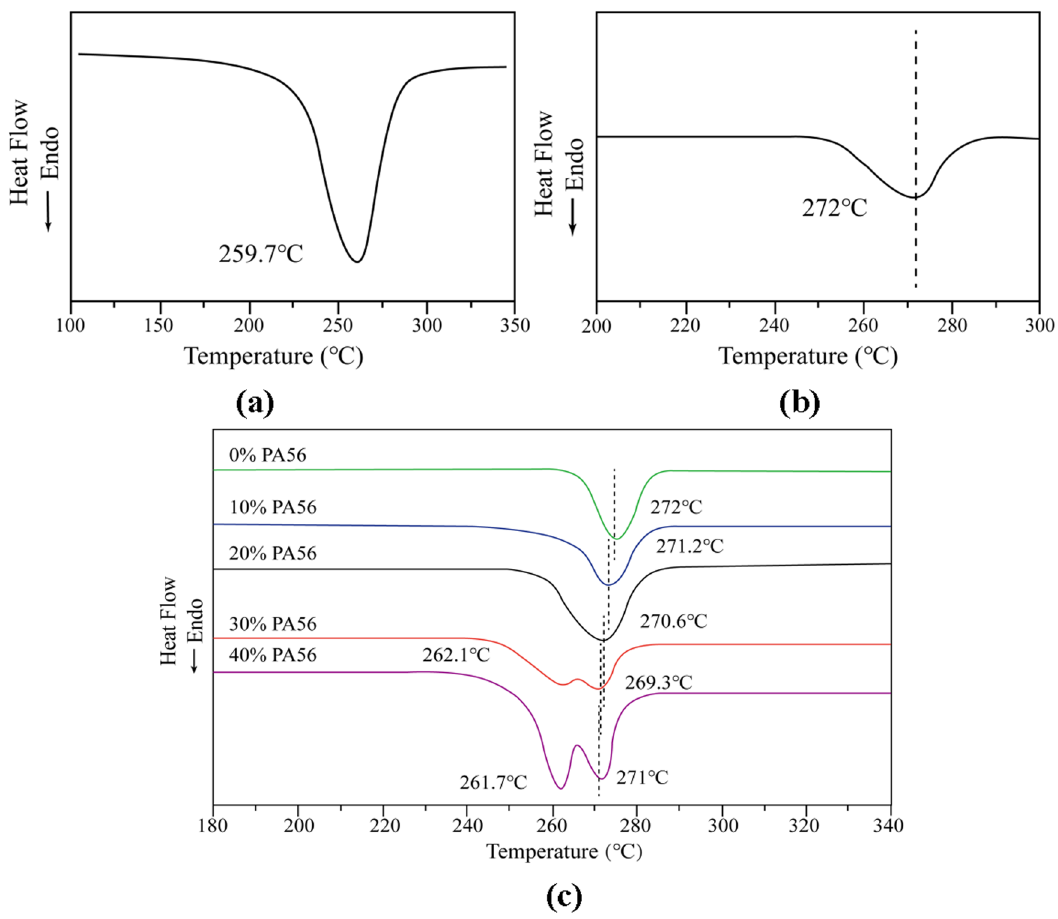
Figure 7: DSC heating curves of ( a ) melting point of bio - based PA56, ( b ) melting point of PET, and ( c ) bio - based PA56/PET blends.